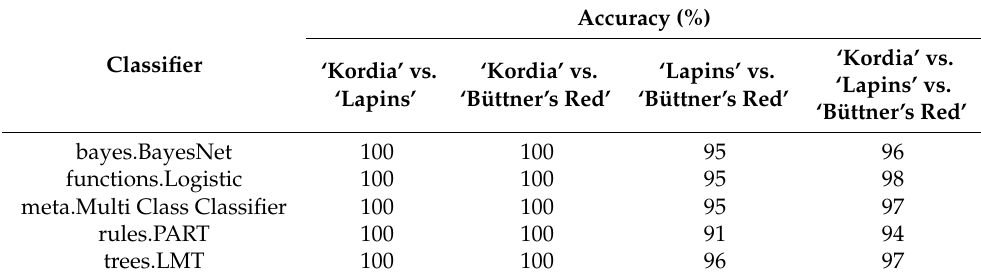
Table 6. The accuracy of discrimination of the endocarp (pit) of different sweet cherry cultivars based on sets comprised of selected textural and geometric